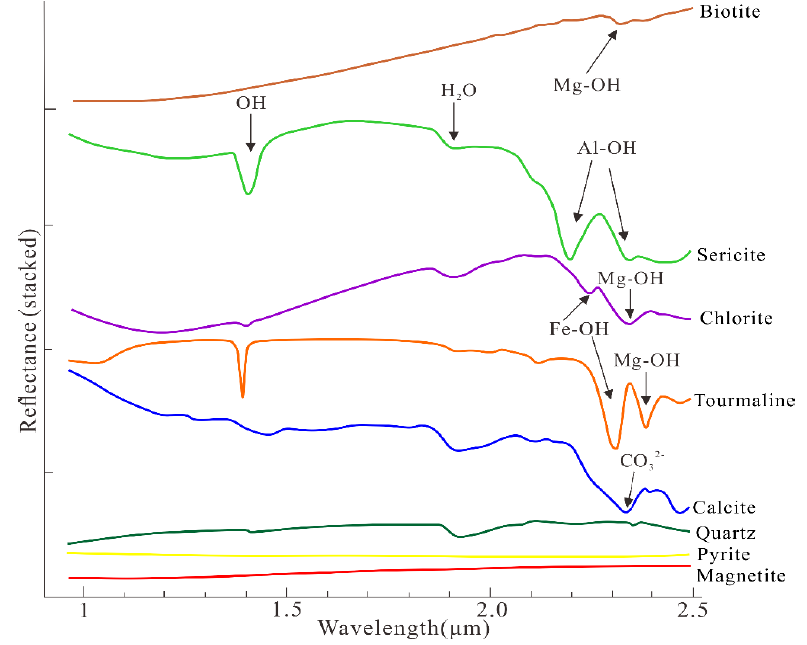
Figure 14. The endmember spectral library for the short-wave infrared spectroscopy (SWIR) mineral